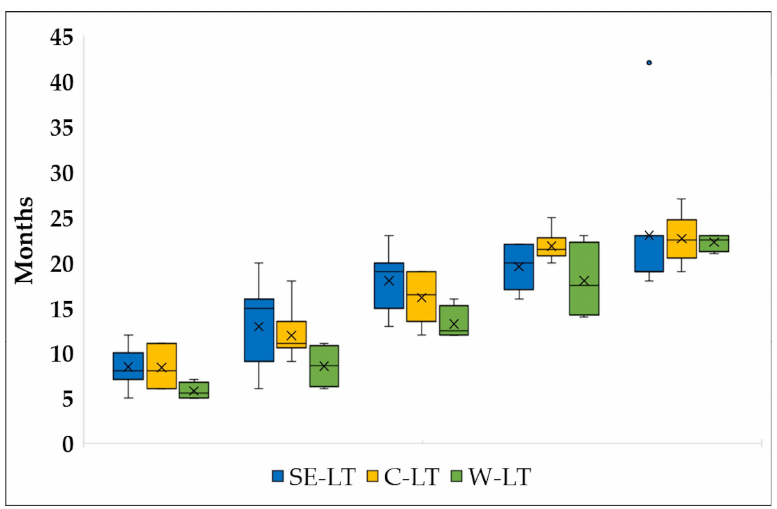
Figure 7. Box plot based on hydrological drought duration in months (the accumulation period in- creases from left to right: 1, 3, 6, 9 and 12,